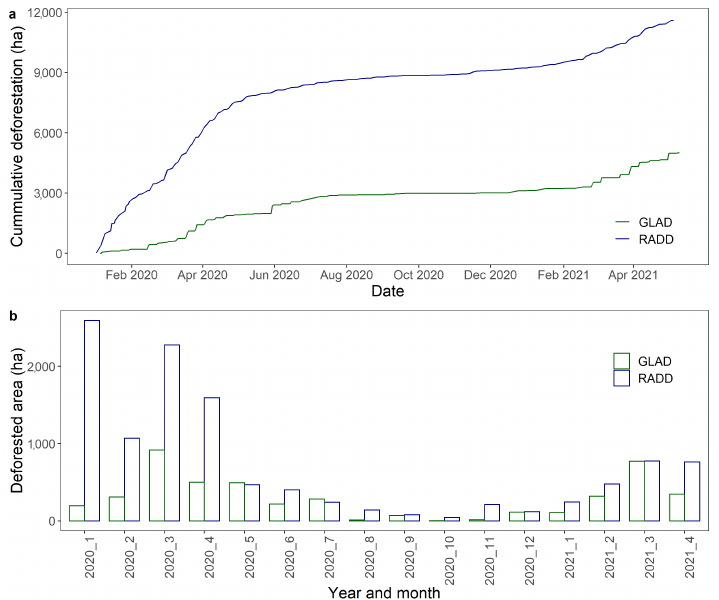
Figure 5. The summary of the alert products for both RADD and GLAD products in 2020 and early 2021. ( a ) shows the cumulative deforested area at least every week, while ( b ) shows the monthly sum. Large gap in the accumulated deforestation is driven by the relatively high RADD alerts in the first few months.